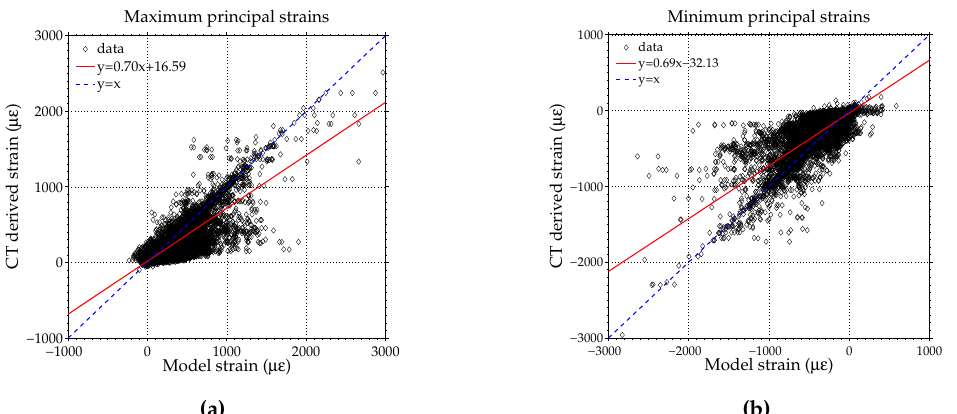
Figure 8. Comparison between the maximum (a) and minimum (b) principal strains across the surface of the structural model ( x -axis) and CT derived model ( y -axis). Lines of best fit are shown in red for each case, with the y = x line shown in dashed